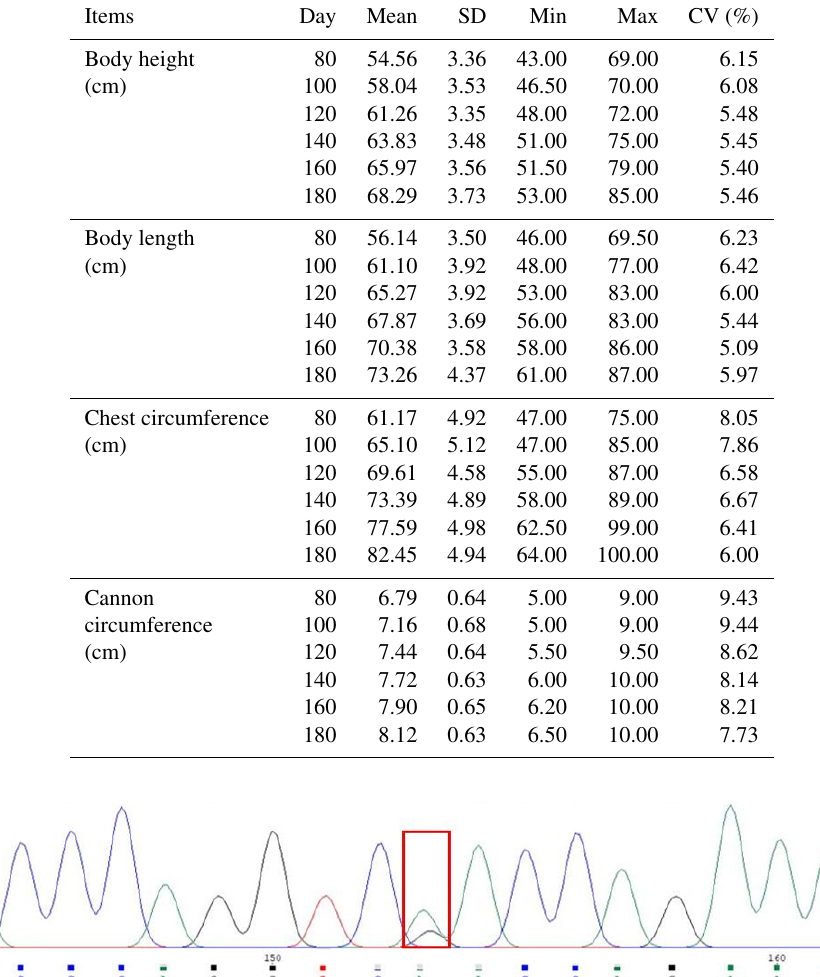
Table 2. Descriptive statistics of body size traits.